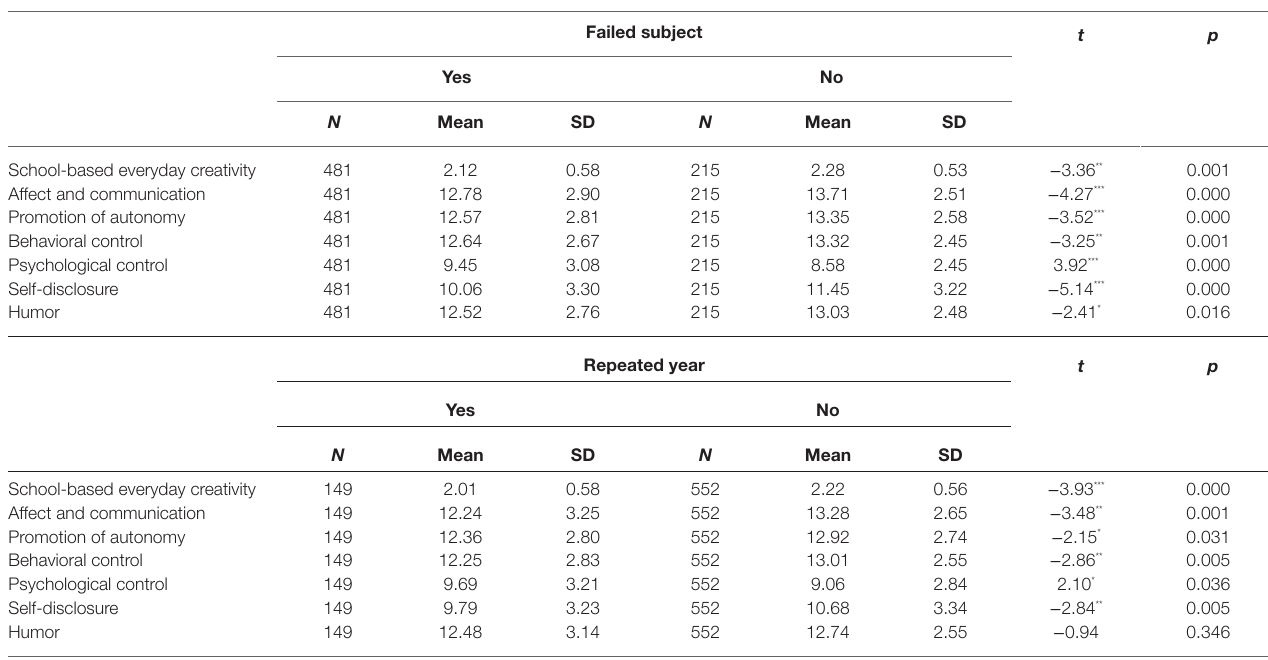
TABLE 2 | Digital creativity and parenting style. Descriptive statistics and t test by failed subject/repeated year.